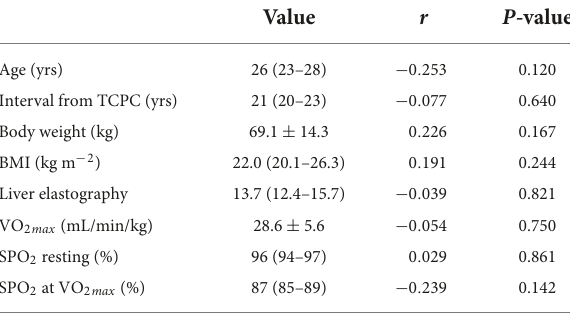
TABLE 4 Correlations between clinical data and procollagen III amino-terminal peptide (PIIINP) at study.